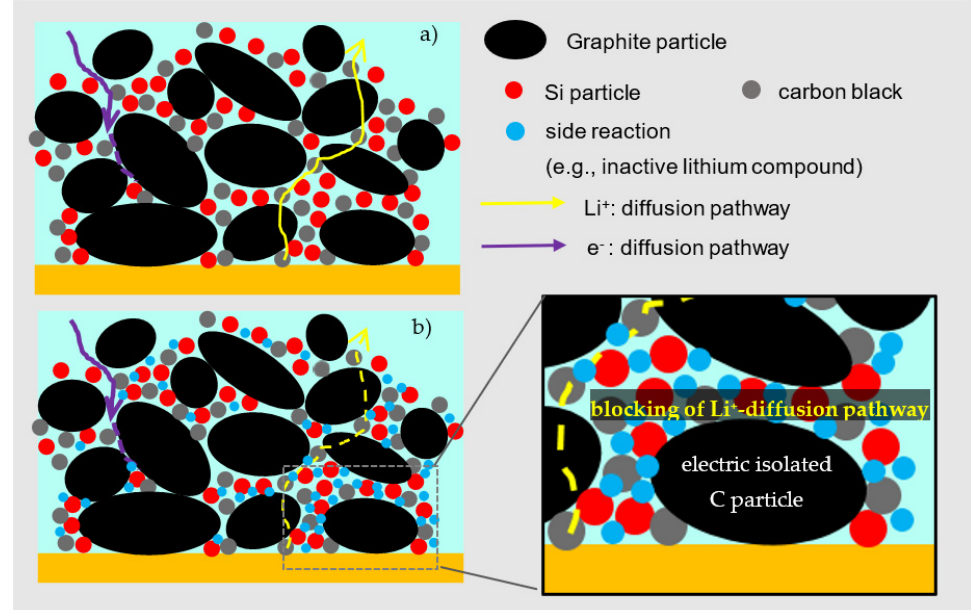
Figure 12. Schematic representation of the silicon–graphite electrode and electron diffusion pathways within the composite electrodes: ( a ) in a fresh state and ( b ) in a cycled state.